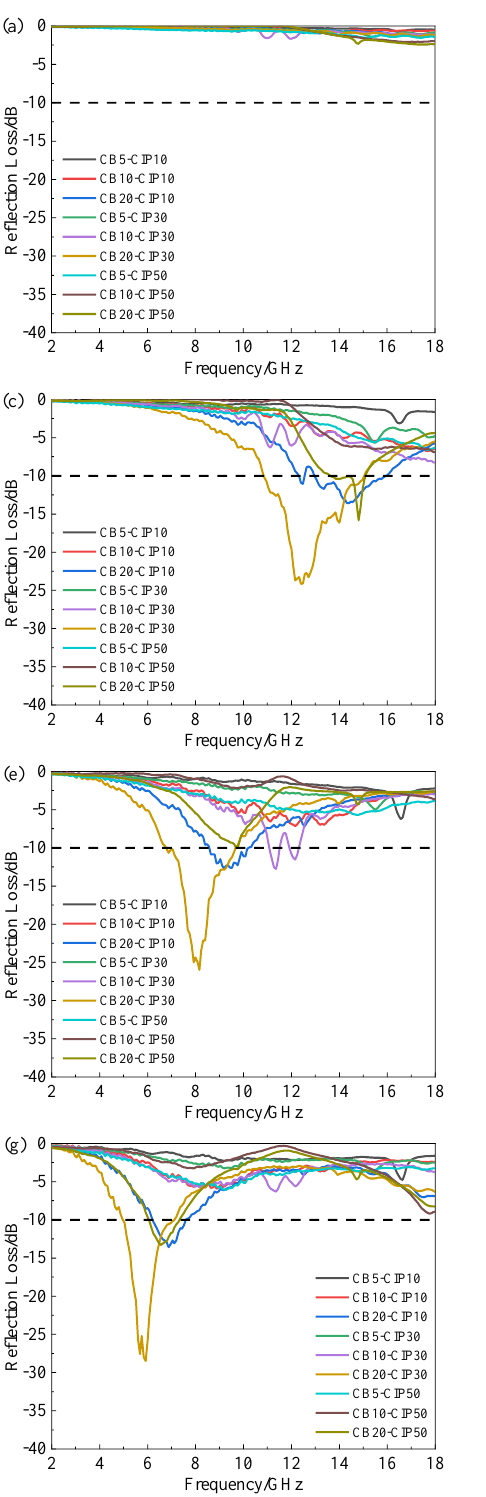
Figure 4. RL diagram of the CB-CIP/PLA composites with different thicknesses: ( a ) 1 mm; ( b ) 1.5 mm; ( c ) 2.0 mm; ( d ) 2.5 mm; ( e ) 3.0 mm; ( f ) 3.5 mm; ( g ) 4.0 mm.